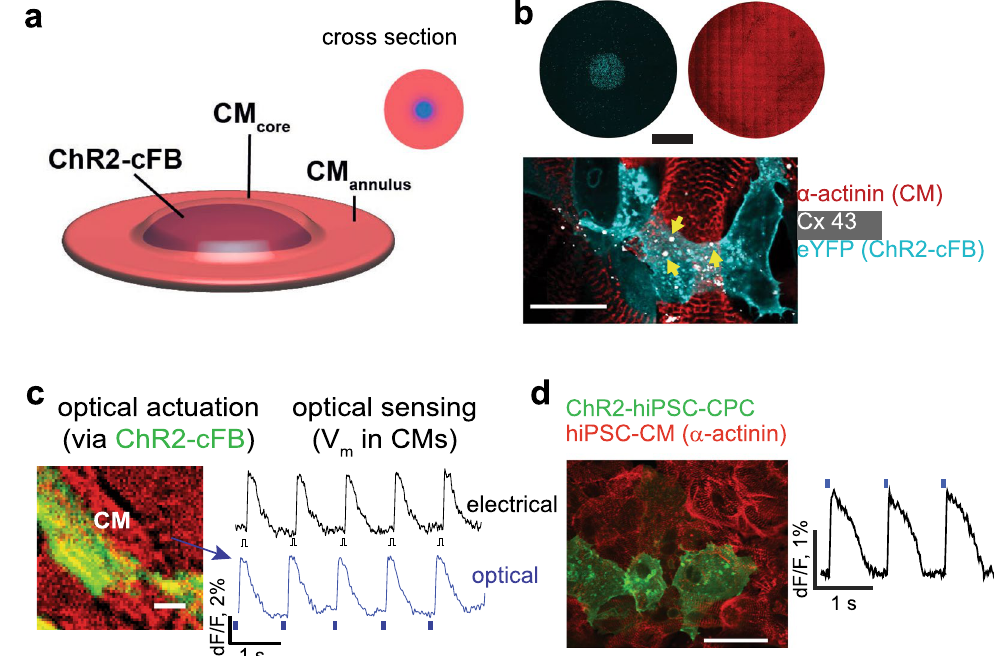
Figure 2. Experimental model of coupling optogenetically-modified nCMs and non-modified CMs. ( a ) Schematic view of the two-layer patterned co-culture of ChR2-cFB and CMs used in this study. A patterned smaller-diameter region of ChR2-cFB (blue core) forms the first layer, covered by a larger CM layer (red circle). ( b ) Immunofluorescent images of ChR2-cFB reported by eYFP (cyan) and CM labeled by α-actinin (red). Black scale bar is 4 mm. Yellow arrows indicate gap junctions (Cx43, white) detected between the two layers of CM and ChR2-cFB. White scale bar is 50 µm. ( c , d ) Functional confirmation of electrical coupling between light- sensitized nCMs and non-transformed CMs by optical voltage sensing. ( c ) Optical recording of electrically (5 ms) or optically-triggered (10 ms pulses, 0.31 mW/mm 2 470 nm light) action potentials in non-transformed CMs, co-cultured with ChR2-cFB (eYFP) from neonatal rat hearts. Scale bar is 50 µm. ( d ) Similarly, functional confirmation of electrical coupling is illustrated between light-sensitized human cardiac progenitor cells (ChR2- iPS-CPC) and non-transformed human iPSC-CMs (light pulses were 20 ms, 0.03 mW/mm 2 470 nm). Scale